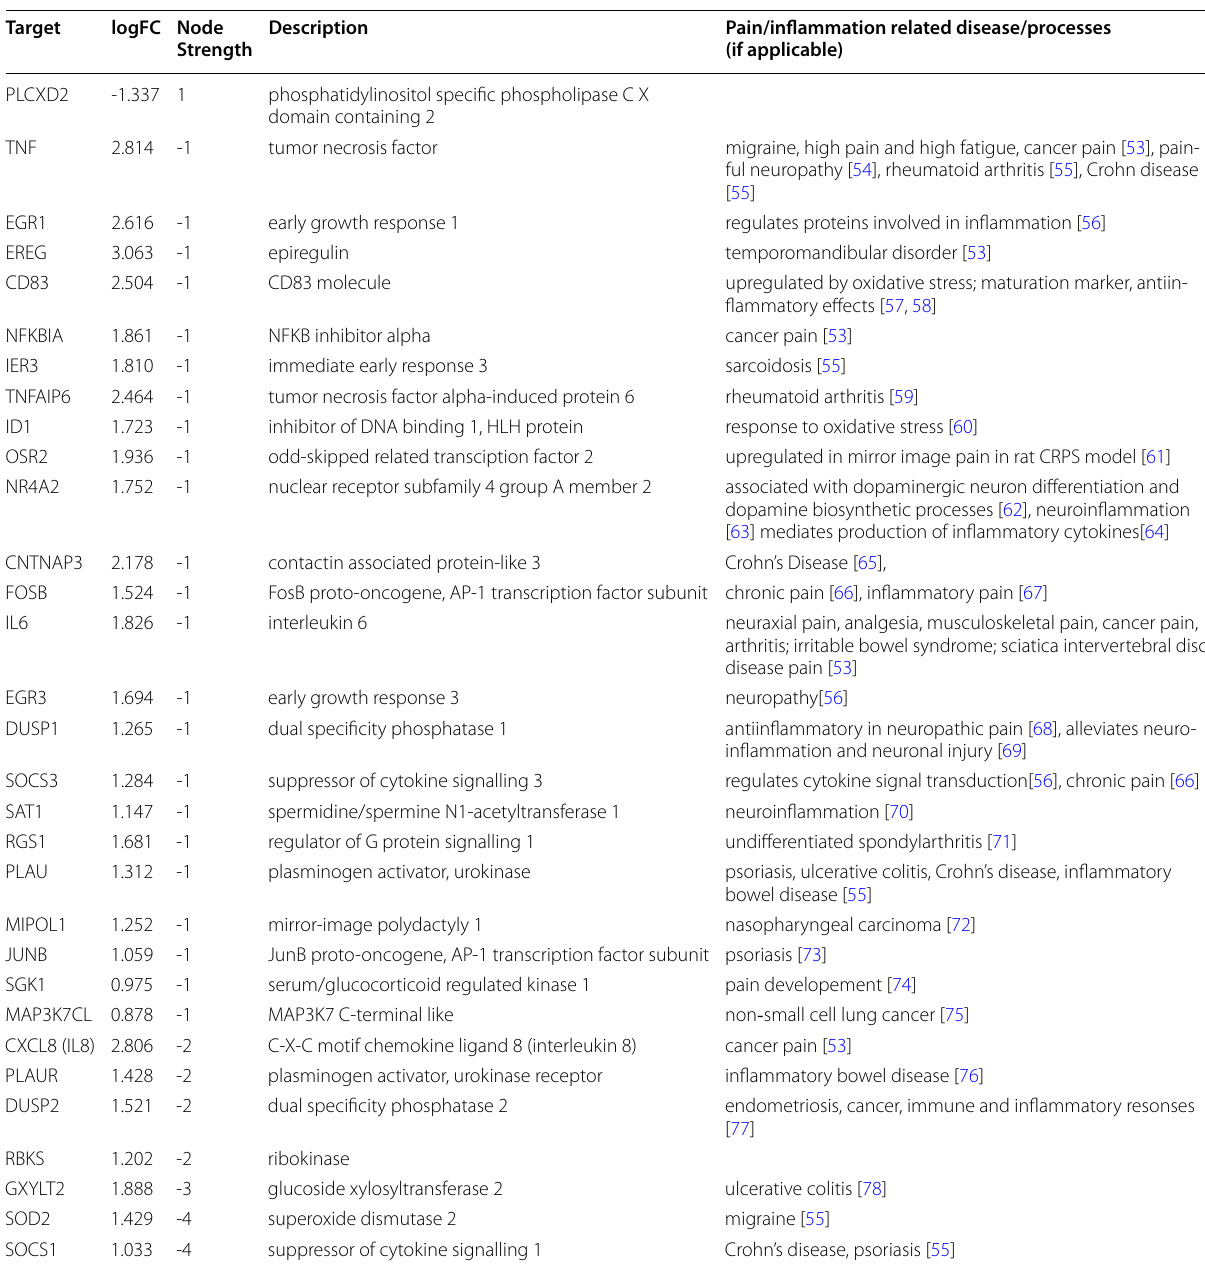
Table 8 Common targets, with similar changes in mRNA- and small RNA sequencing data for validation of predictions at mRNA level in interictal vs healthy comparison. Description and pain phenotype matches based on Human Pain Gene [53], Pain Research Forum [54], DisGeNET [55], and GeneCards [56], complemented with other literature data. logFC: logarithm of the fold change of